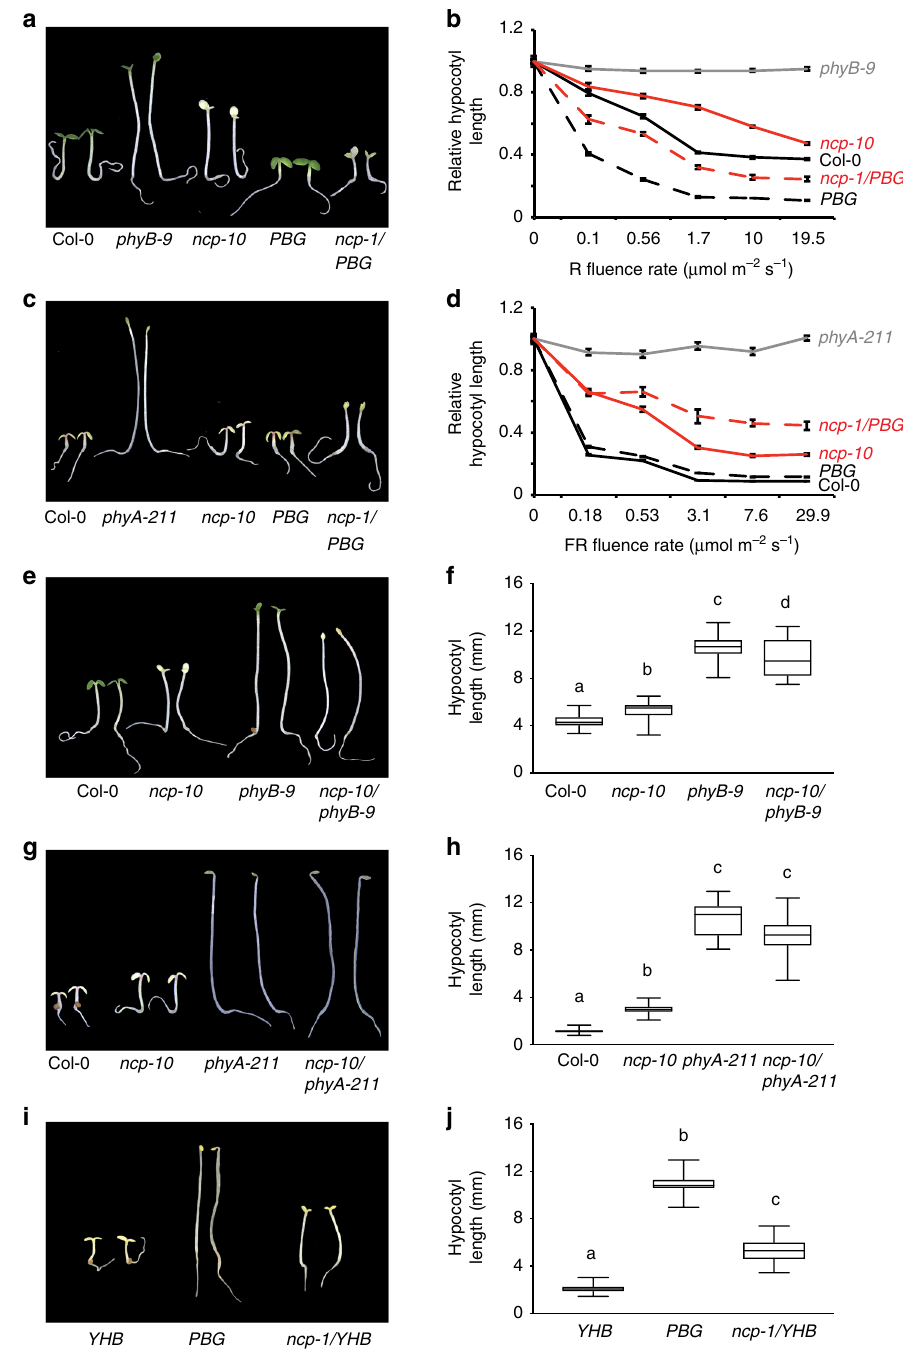
Fig. 2 NCP mediates phytochrome signaling. a Representative images of 4-day-old Col-0, phyB-9 , ncp-10 , PBG , and ncp-1/PBG seedlings grown in 10 μ mol m − 2 s − 1 R light. b R light fl uence response curves showing the hypocotyl elongation responses of 4-day-old Col-0 (solid black line), phyB-9 (solid gray line), ncp-10 (solid red line), PBG (dotted black line), and ncp-1/PBG (dotted red line) seedlings grown in the dark and a series of R light intensities. c Representative images of 4-day-old Col-0, phyA-211 , ncp-10 , PBG , and ncp-1/PBG seedlings grown in 10 μ mol m − 2 s − 1 FR light. d Fluence response curves for FR light showing the relative hypocotyl lengths of 4-day-old Col-0 (solid black line), phyA-211 (solid gray line), ncp-10 (solid red line), PBG (dotted black line) and ncp-1 / PBG (dotted red line) seedlings grown in the dark and a series of FR light intensities. For b and d , error bars represent SE, and hypocotyl length in the light was calculated relative to that in the dark. e , Representative images of 4-day-old Col-0, ncp-10 , phyB-9 , and ncp-10/phyB-9 seedlings grown in 10 μ mol m − 2 s − 1 R light. f Box-and-whisker plots showing hypocotyl length measurements of the seedlings in e . g Representative images of 4- day-old Col-0, ncp-10 , phyA-211 , and ncp-10/phyA-211 seedlings grown in 10 μ mol m − 2 s − 1 FR light. h Box-and-whisker plots showing hypocotyl length measurements of the seedlings in g . i Representative images of 4-day-old dark-grown YHB , PBG , and ncp-1/YHB seedlings. j Box-and-whisker plots showing hypocotyl length measurements of the seedlings in i . For the box-and-whisker plots in f , h , and j , the boxes represent from the 25th to the 75th percentiles, and the bars equal the median values; samples with different letters show statistically signi fi cant differences in hypocotyl length (ANOVA, Tukey's HSD, p ≤ 0.001, n > 28). The source data of the hypocotyl measurements in b , d , f , h , and j are provided in the Source Data fi